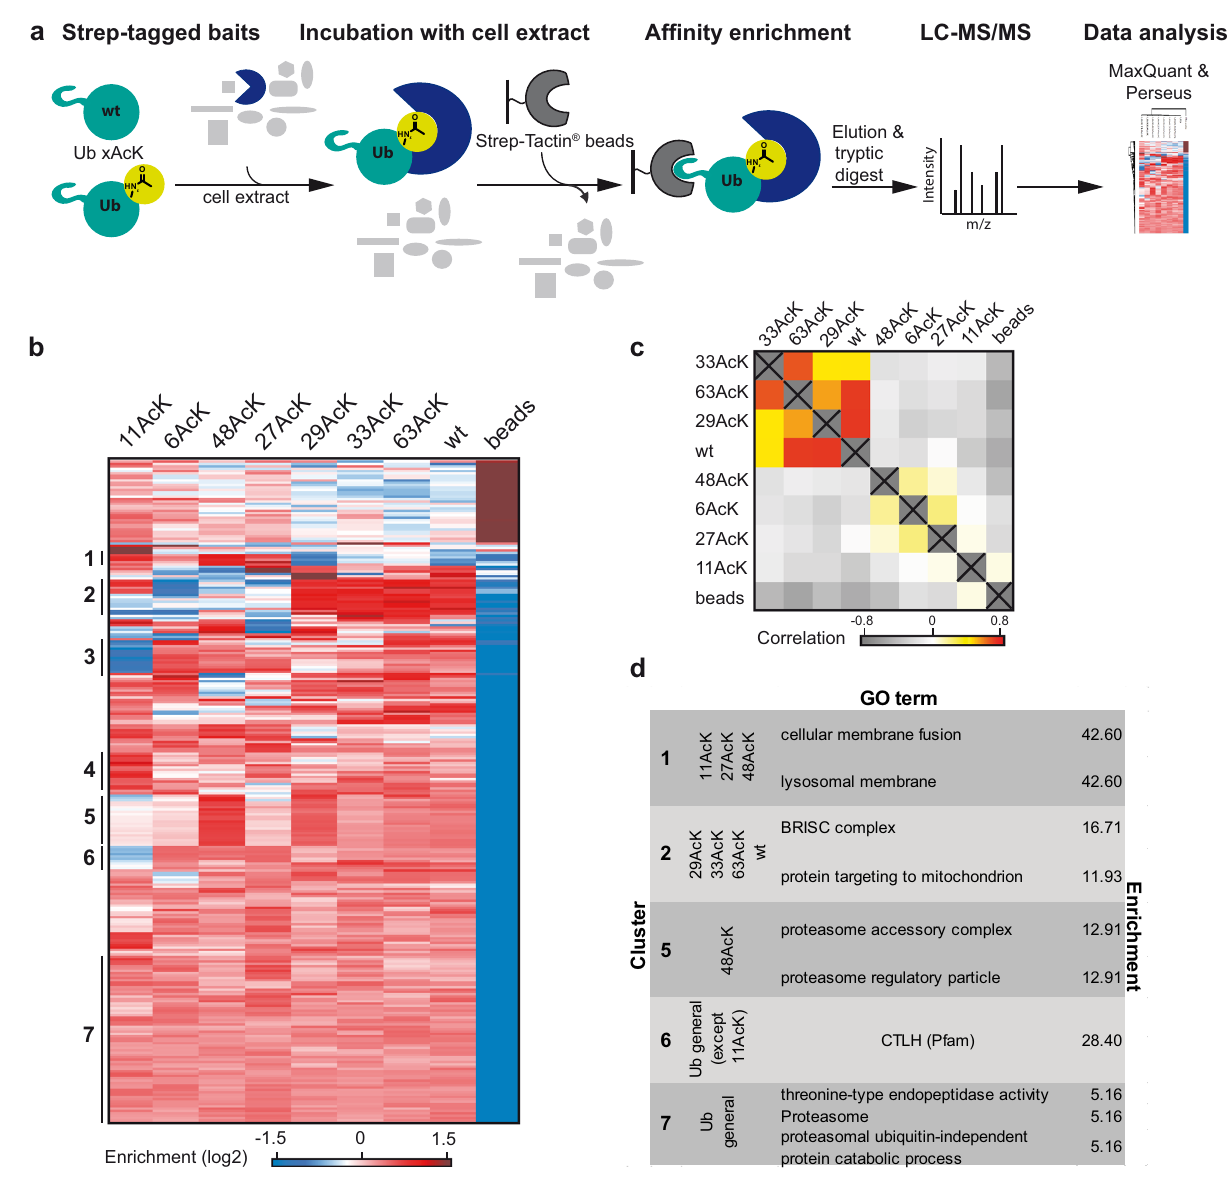
Fig. 5 | Identi fi cation of interactors of acetylated Ub variants. a Schematic overview of the AE-MS work fl ow for the identi fi cation of interactors of acetylated Ub variants.Nonmodi fi edUb (wt)and eachoftheseven site-speci fi callyacetylated Ub variants (Ub xAcK) were used as bait molecules for af fi nity enrichment and incubated with HEK293T cell extract. Empty beads were used as control. b Hierarchical clustering of statistically signi fi cant interactors (rows) of the differ- ent bait molecules (columns). Red indicates enrichment, whereas blue indicates